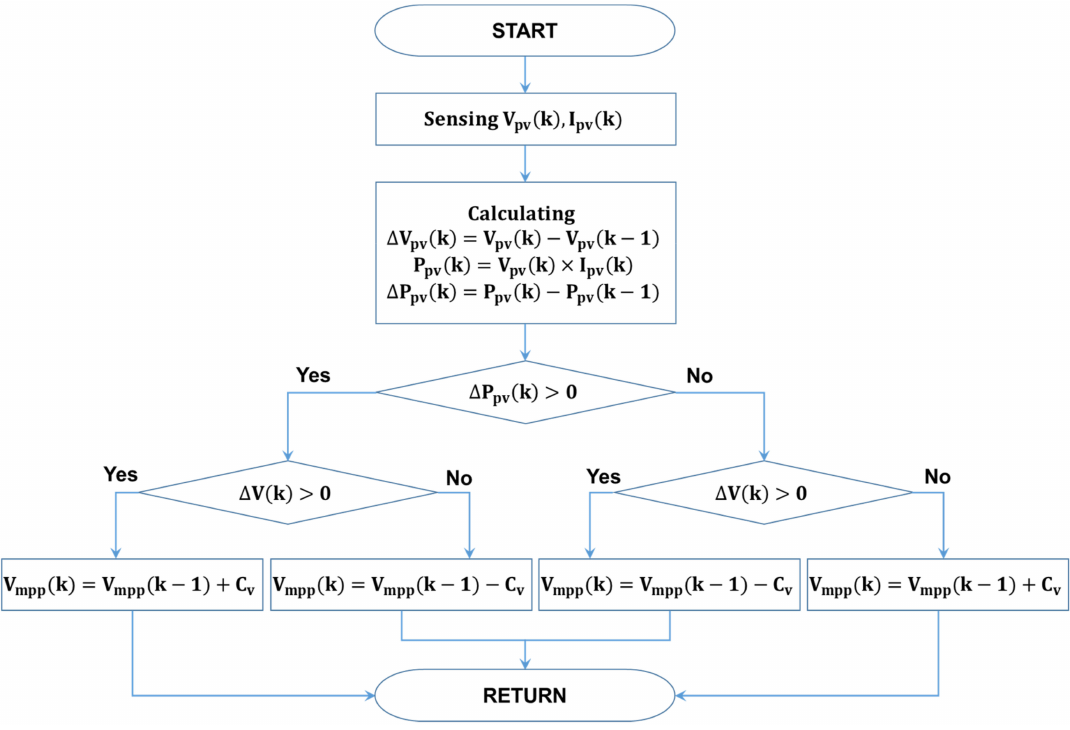
Figure 7. Flowchart of P&O